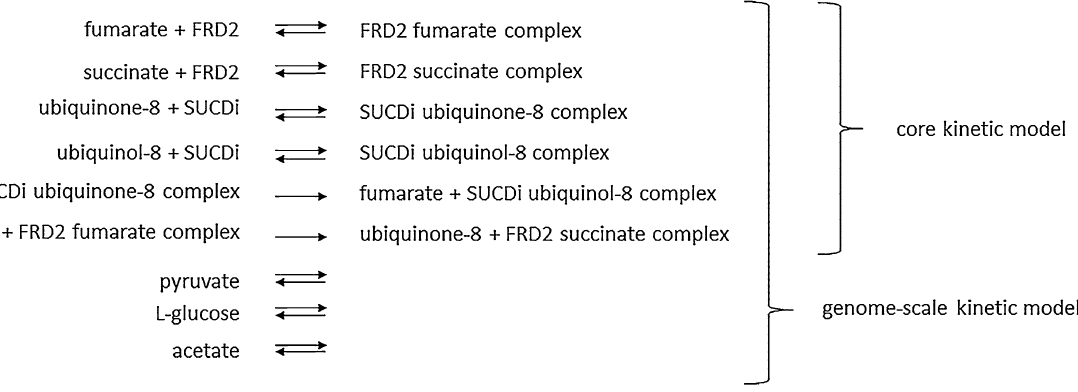
Figure 2. Illustration of the reduced core and genome-scale kinetic models obtained by reduction of a mass action kinetic model. The reduced core kinetic model comprises ten components and ten reactions, while the reduced genome scale kinetic model consists of 13 compounds and 16 reactions. (fumarate reductase—FRD2, succinate dehydrogenase—SUCDi). The concentration of the components present in the reduced networks can be used to model the concentration of all other components in the original networks.